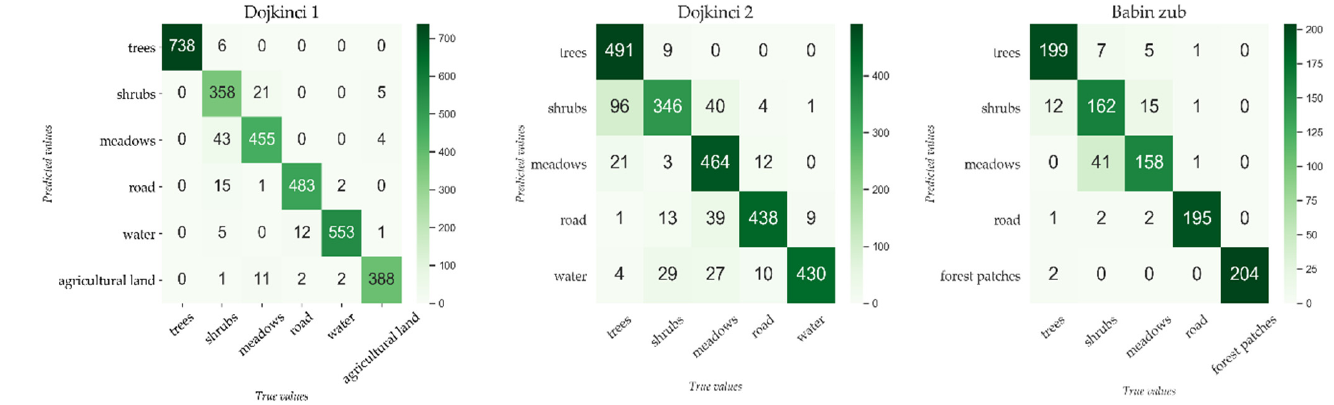
Figure 4. Confusion matrices of RF classifier for Dojkinci1, Dojkinci2, and Babin zub.